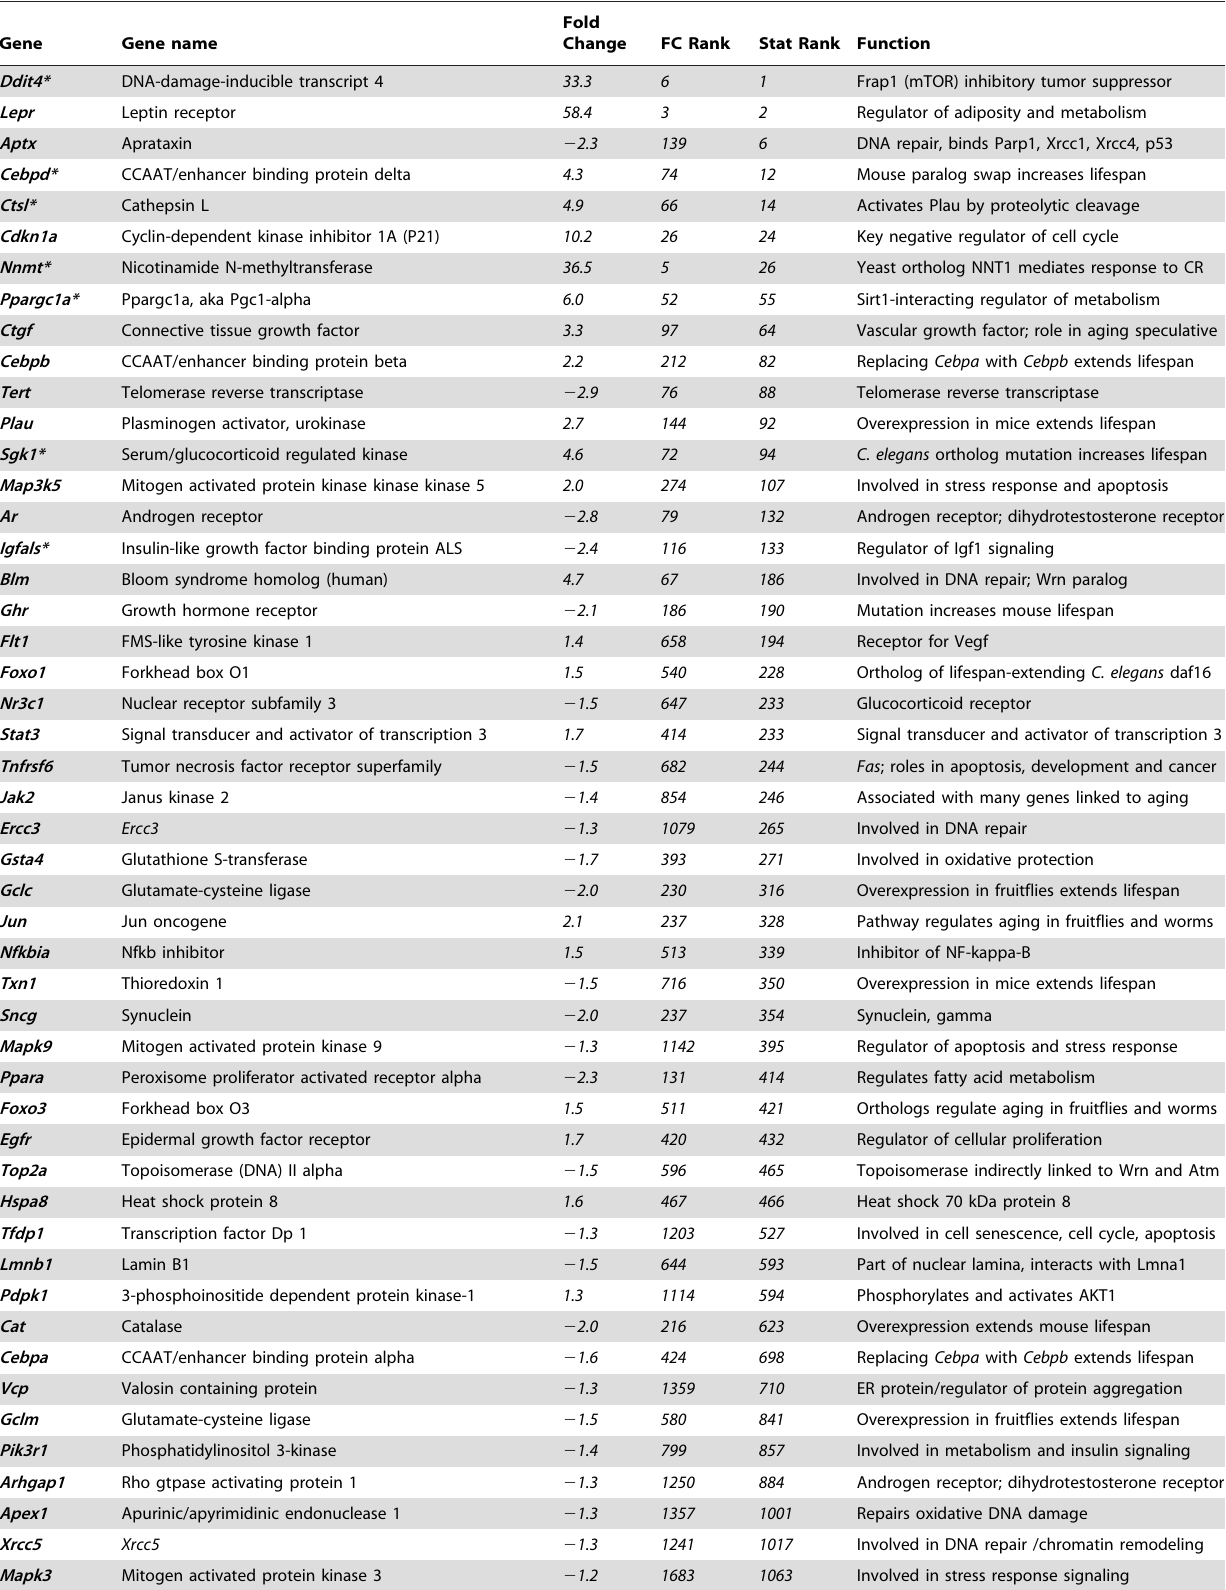
Table 1. Aging-related genes upregulated or downregulated by CR, q , 0.01.